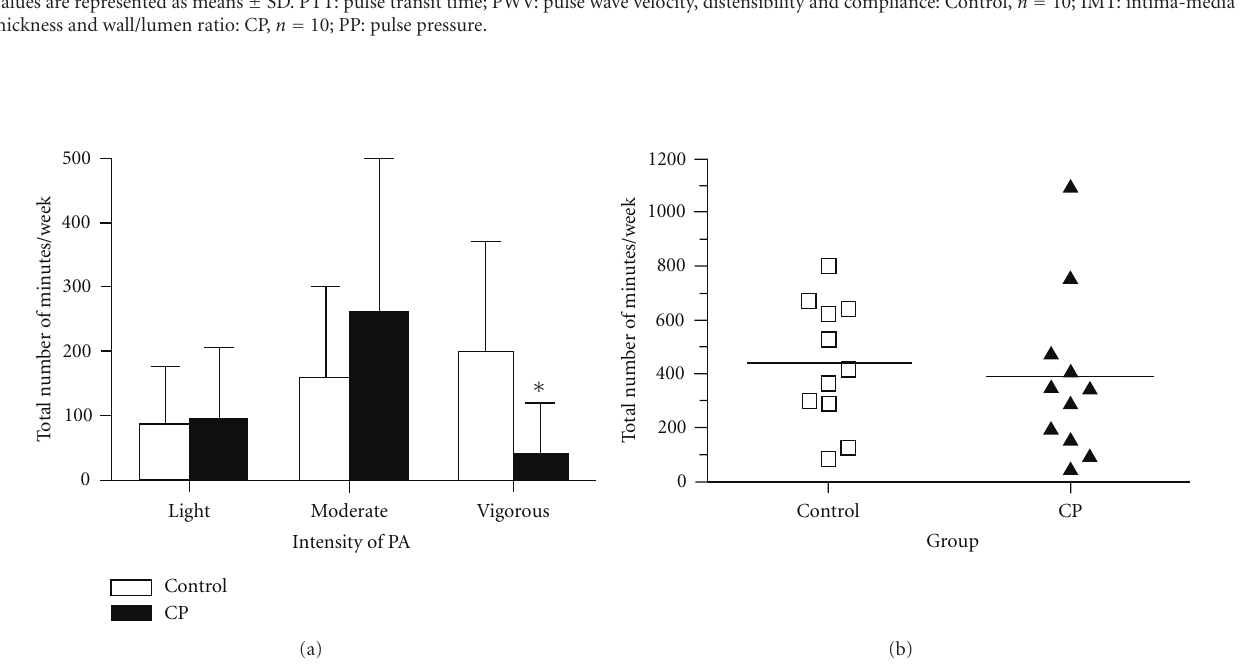
Figure 1: (a) Group comparisons of weekly PA according to intensity. (b) Group comparisons of total PA (summation of all three intensities) performed in one week, individual data and group means presented; n = 11 in each